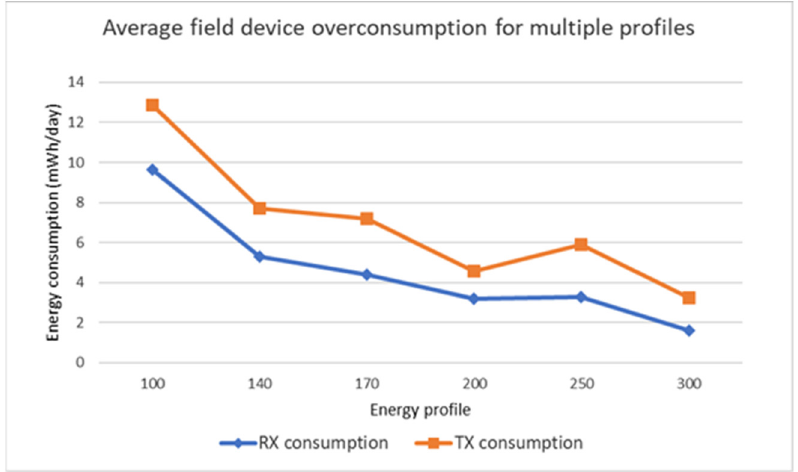
Figure 8. Average field device energy consumption per day exceeding the energy